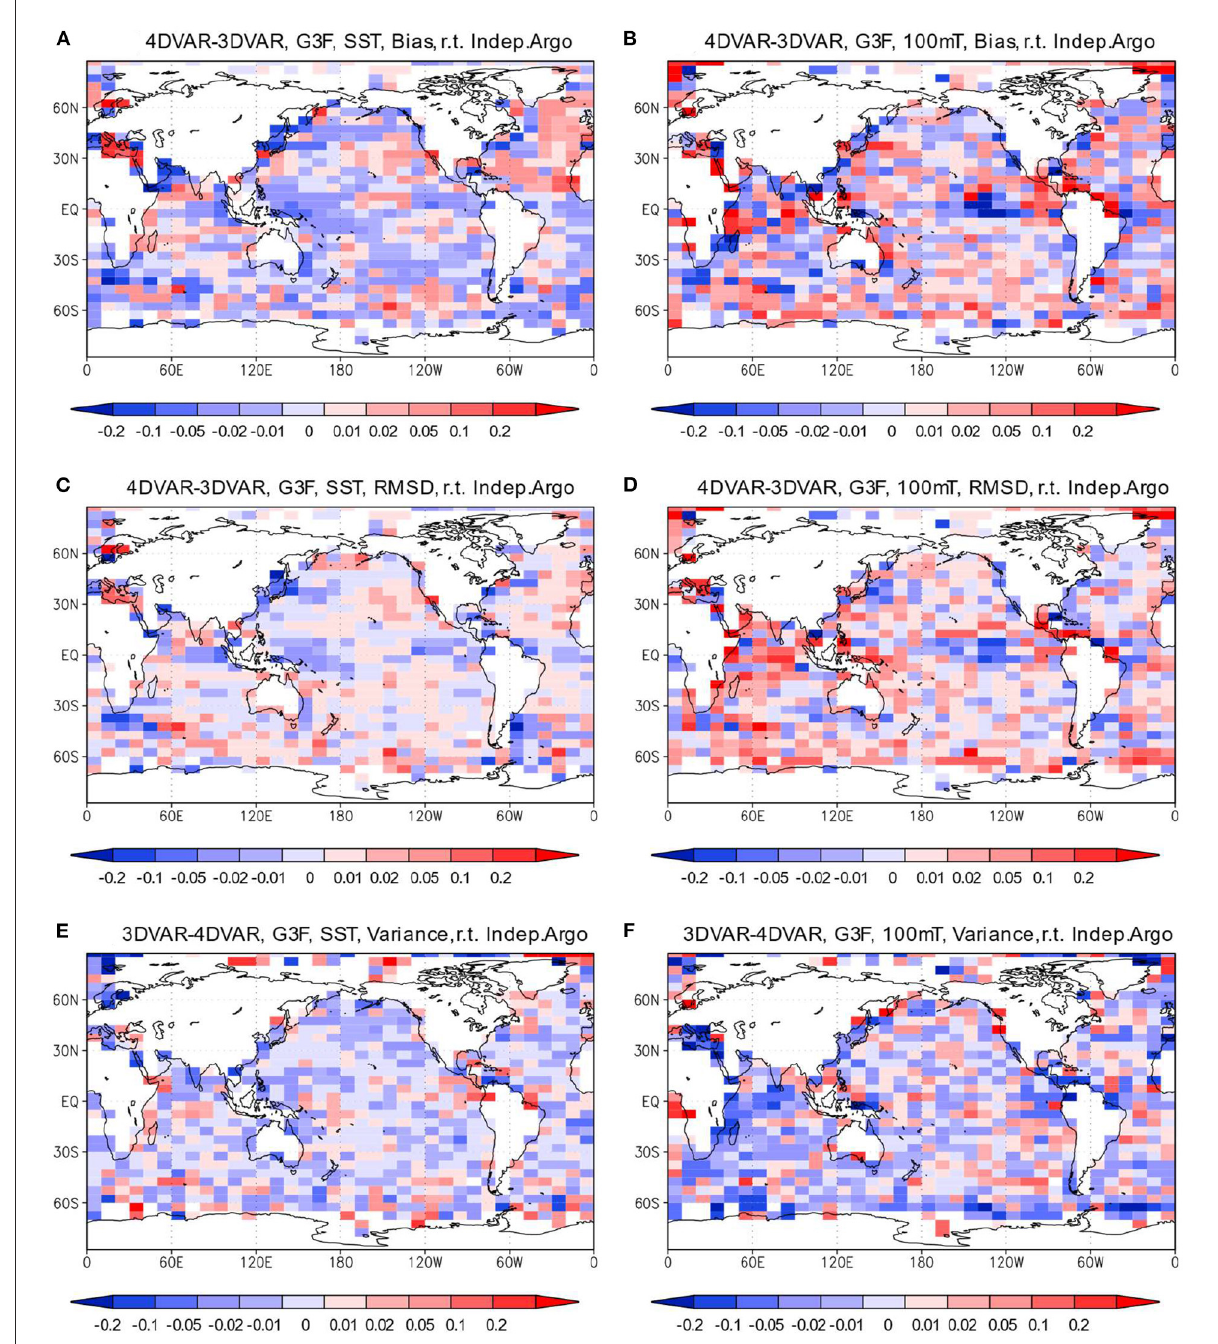
FIGURE9 Difference of the bias absolute values, RMSDs, and relative standard deviations of the MOVE-G3F temperature relative to the independent Argo float data between the 4DVAR and 3DVAR Runs. (A, B) Difference of the bias absolute values at the surface and 100m depth. (C, D) Difference of the RMSDs at the surface and the 100m depth. (E, F) Difference of the relative standard deviations at the surface and the 100m depth. Blue colors mean that the bias absolute value and the RMSD are smaller for the 4DVAR Run in (A–D) , and that the relative standar deviation is larger for the 4DVAR Run in (E, F) . Units in ◦